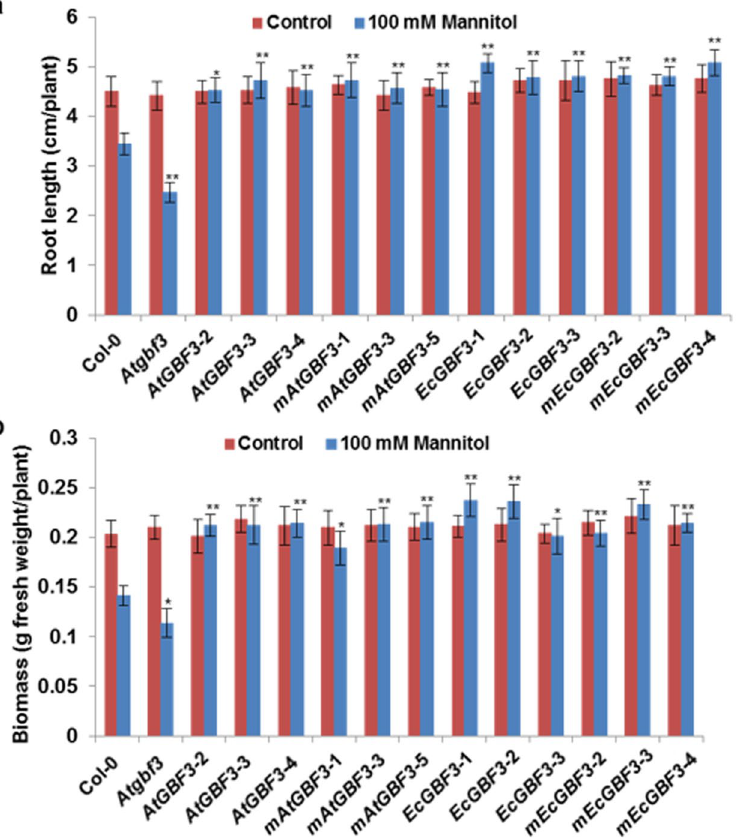
Figure 3. Improved osmotic stress tolerance of AtGBF3 and EcGBF3 transgenic Arabidopsis plants. A week old hygromycin resistant T 3 transgenic seedlings along with Col-0 and Atgbf3 mutant seedlings were transferred on to medium (1/2 MS, 0.5% sucrose and 0.1% phytagel) containing 100 mM mannitol and growth performance was measured after 10 days. Root length ( a ) and Biomass ( b ) were measured using plants carefully uprooted from the media and blotted on paper towel to remove any media. The values are means ± SE (n = 10). t test was used to show the statistical significance of the differences in the means of Atgbf3 mutant or transgenic plants from Col-0 plants. * and ** indicate significant difference from Col-0 plants at P ≤ 0.05 and P ≤ 0.01, respectively. Atgbf3 , AtGBF3 mutant; AtGBF3 -2, -3 and -4, transgenic lines overexpressing AtGBF3 ; mAtGBF3 -1, 3 and -5, transgenic lines overexpressing AtGBF3 in the Atgbf3 mutant background; EcGBF3 -1, 2 and 3, transgenic lines overexpressing EcGBF3 ; mEcGBF3 -2, 3 and 4, transgenic lines overexpressing EcGBF3 in the Atgbf3 mutant